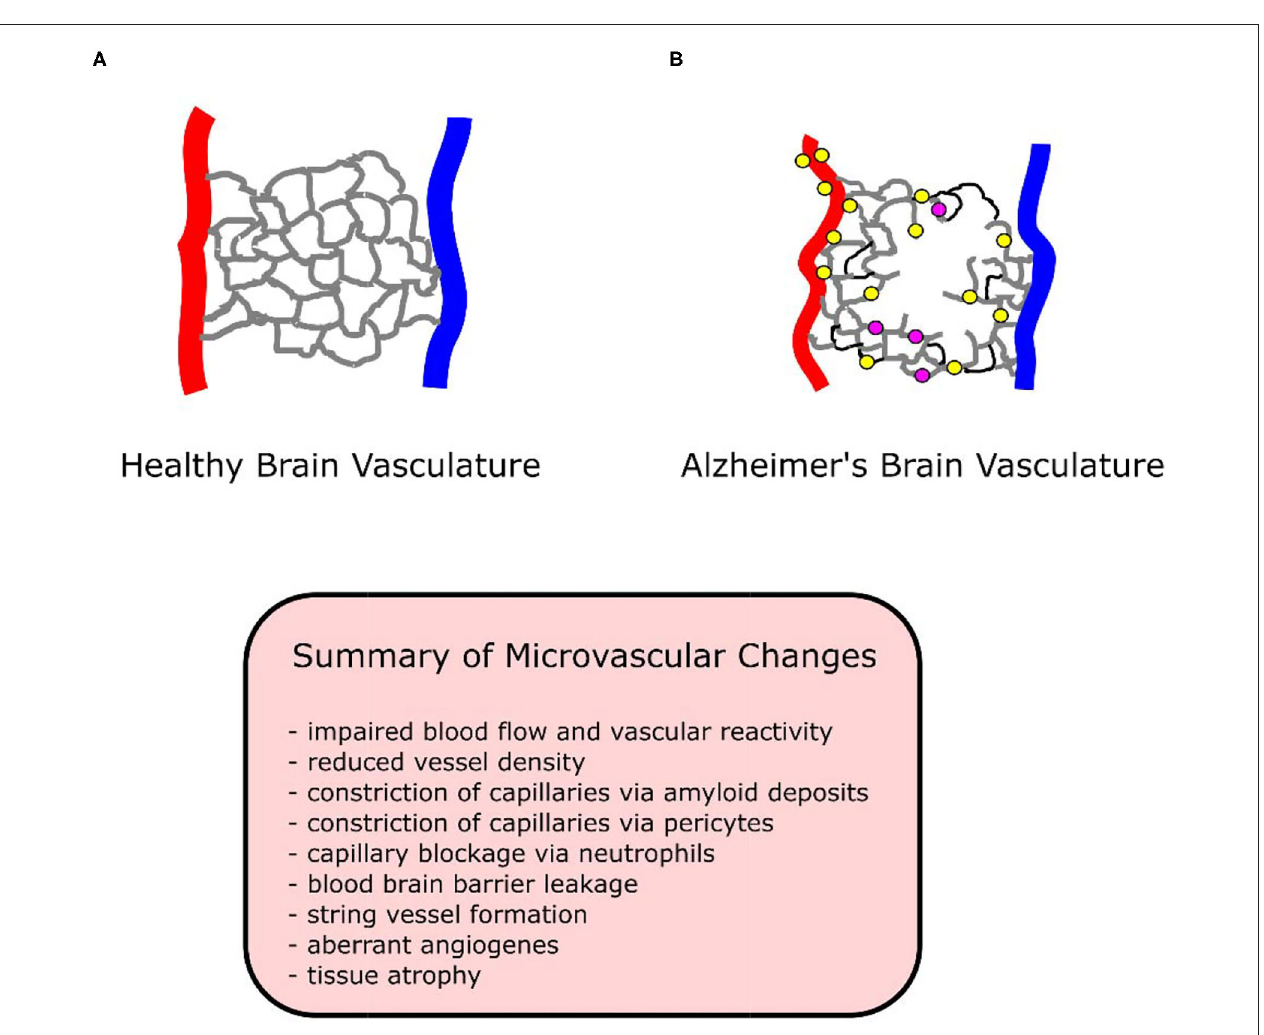
FIGURE 1 | Diagram of healthy and Alzheimer’s brain vasculature. (A) Diagram of healthy brain vasculature. Penetrating arteries ( red ) and veins ( blue ) are connected via a capillary mesh ( gray ). (B) Diagram of Alzheimer’s brain vasculature. Deposition of amyloid ( yellow dots ) in the vascular bed causes vascular dysfunction and loss in AD, with proliferation of vessels around missing vasculature (Meyer et al., 2008). String vessels ( black ) with no blood cells form as endothelial cells undergo apoptosis. Neutrophils ( purple dots ) stall a small portion ( ∼ 2%) of capillaries, reducing blood flow in the network. Penetrating vessels have a tortuous shape, with a tendency to decrease in diameter with aging in AD (Dorr et al., 2012). Capillaries been reported to increase (trending) in diameter in APP/PS1 mice (Lu et al., 2019), experience swelling in APP23 mice (Meyer et al., 2008), decrease in diameter in P301L tau mice (Bennett et al., 2018), and to form “string” vessels with no flow or blood cells in humans (Hunter et al., 2012). Tissue undergoes atrophy, causing vascular shrinkage and functional brain deficits such as memory loss.